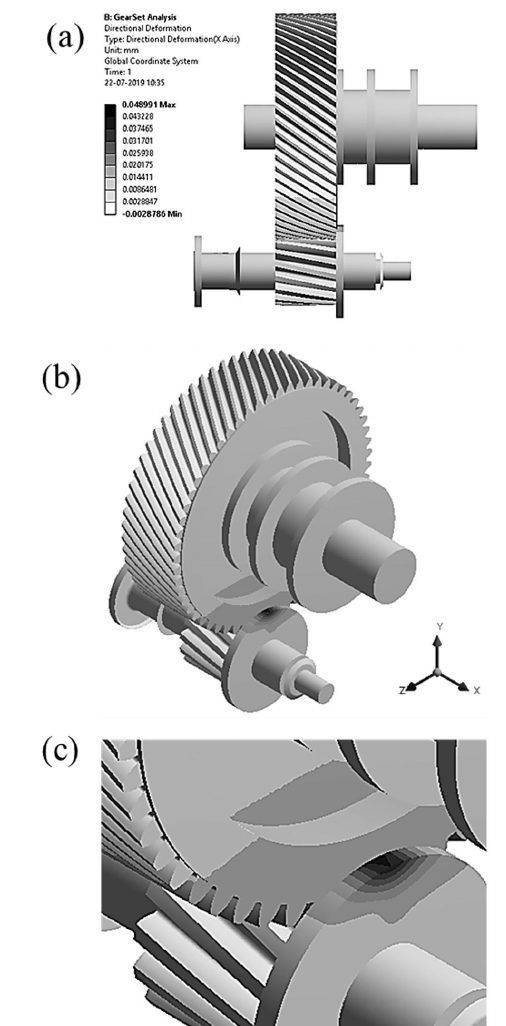
Figure 6. ( a ) Deformation computed in gearset in x-direction; ( b ) isometric view of gearset with deformation contours; ( c ) magnified view of deformation contours.